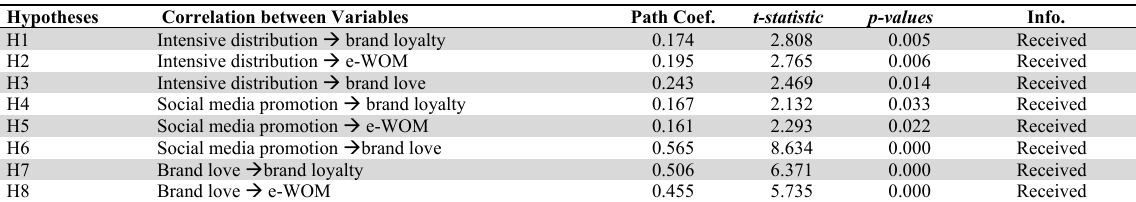
Path Coefficient